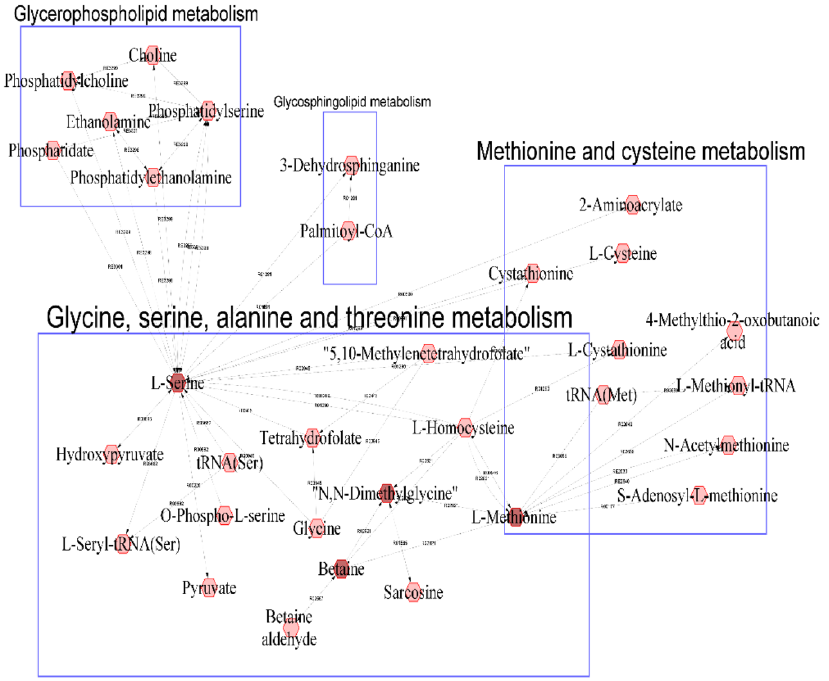
Figure 1. A compound network of metabolites that had significant ( P < 0.05) genetic correlations with average daily gain in the quarantine nursery. Input metabolites are shown in dark red color and chemical reactions are represented as